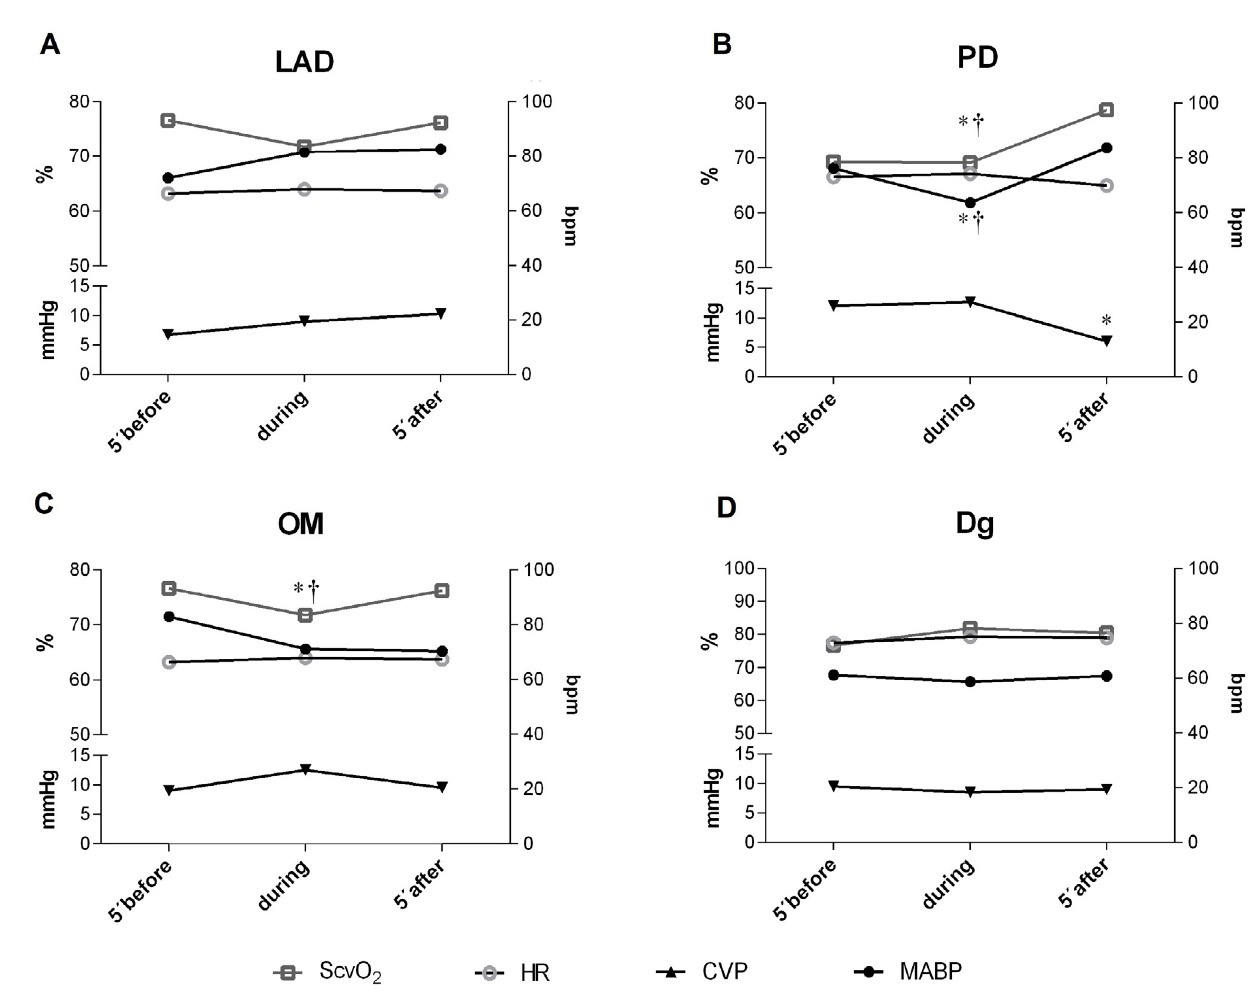
Fig. 2 – Hemodynamic changes during coronary artery bypass graft anastomosis. CVP=central venous pressure; Dg=diagonal; HR=heart rate; LAD=left anterior descending; MABP=mean arterial blood pressure; OM=obtuse =central venous oxygen marginal; PD=posterior descending; ScvO 2